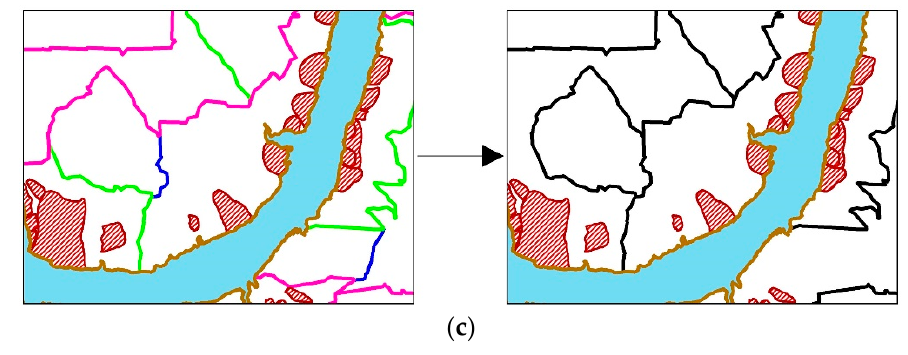
Figure 6. The merging of prediction regions. ( a ) The merging of prediction regions which separate landslides; ( b ) the merging of adjacent small regions including landslides, which are far from other landslides area; ( c ) the preservation of large regions without landslide.